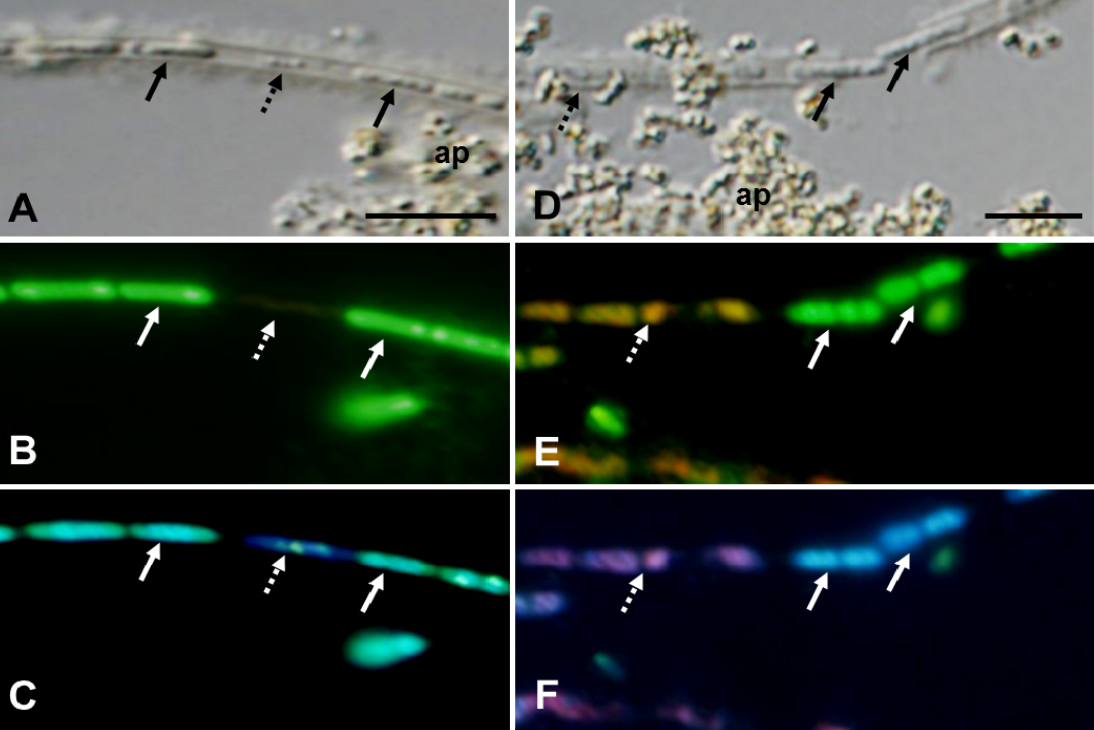
Figure 3. OUMS1 and associated structures cultivated in groundwater for 3 ( A – C ) and 7 days ( D – F ). DIC images ( A , D ) and L/D- ( B , E ) and DAPI- ( C , F ) fluorescent images. ( A – C ) Line of cells (solid arrows) and cell remnants (dotted arrow) enclosed in a thick-walled sheath. Fully shaped cells (solid arrows) with a live response and sign of nucleic acids and cell remnants (dotted arrow) lacking a vital response and nucleic acids. Assembled particles (ap) are seen at discrete locations along the sheaths. And ( D – F ) fully shaped live cells with fluorescing nucleic acids (solid arrows) and deformed, and dead cells with damaged DNA (dotted arrow) in a thick-walled sheath. Scale bar = 5 μ